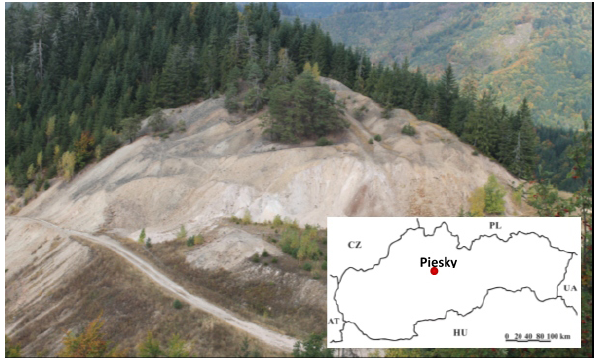
Figure 1. The studied area in the surroundings of Špania Dolina and Staré Hory (central